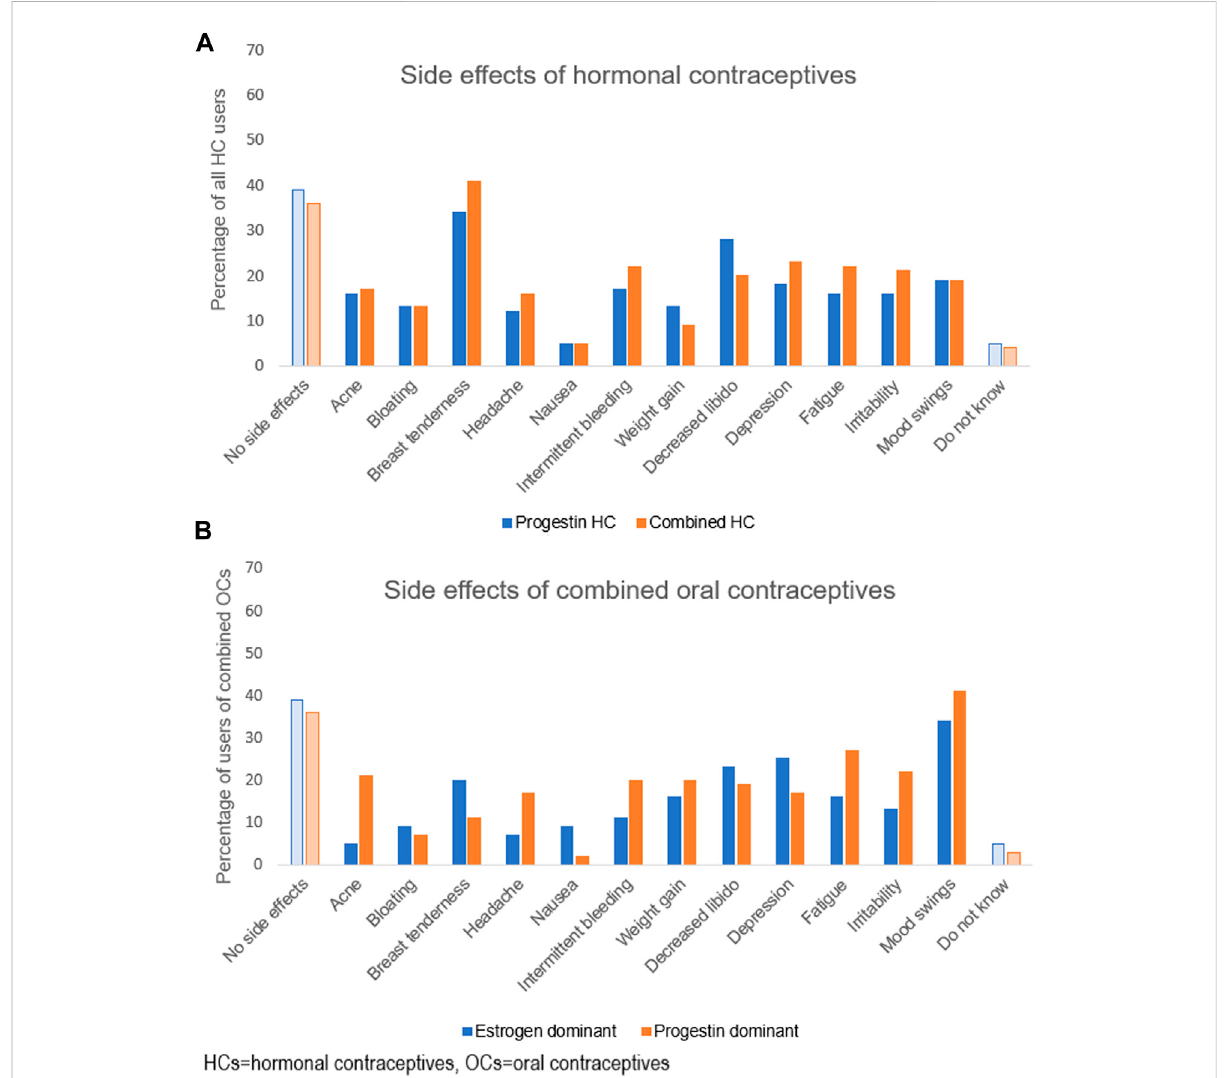
FIGURE 4 Sideeffectsexperiencedbytheathletesusinghormonalcontraceptives,inpercentage.In (A) sideeffectofhormonalcontraceptivescontaining progestins alone (49%, n = 299) and hormonal contraceptives containing a combination of progestins and ethinyl estradiol (51%; n = 316). A total of 615 (91%) users of hormonal contraceptives answered this question. In (B) side effects of combined oral contraceptives, divided into estrogen dominant oral contraceptives (18%; n = 56) and progestin dominant oral contraceptives (51%; n = 156). The oral contraceptives of non-speci fi c dominance (31%; n = 95) (data not